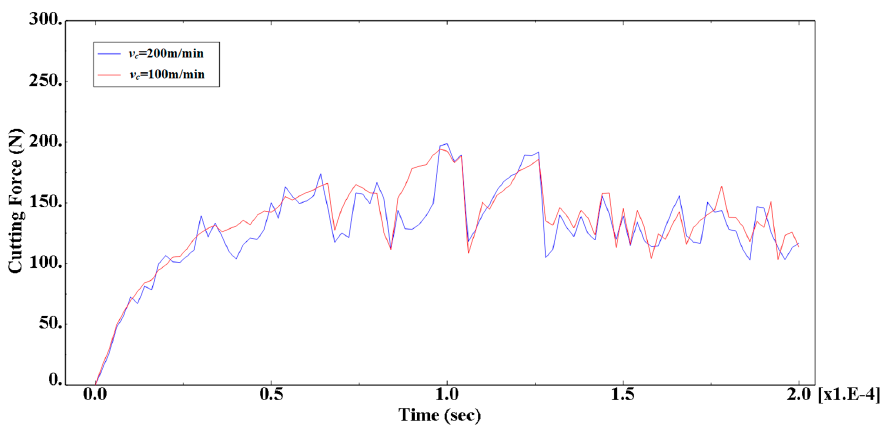
Figure 24. Comparison of cutting force for different cutting speeds.